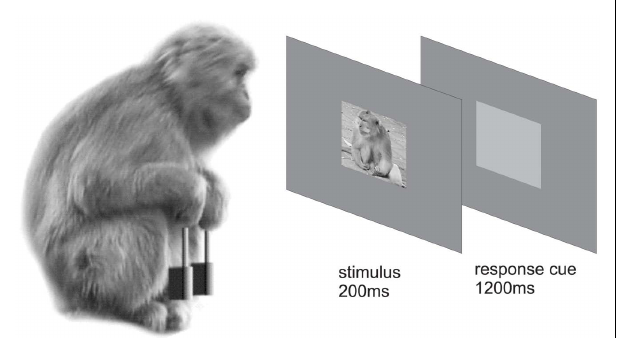
FIGURE 1 | Categorization task. After successfully fixating on a central fixation spot and concurrently pressing two levers for 500ms, a stimulus was presented for 200ms. Immediately afterward, a light gray response cue was presented for 1200ms during which the macaque had the opportunity to categorize the previously seen image as a “flower” or a “monkey” by releasing the appropriate